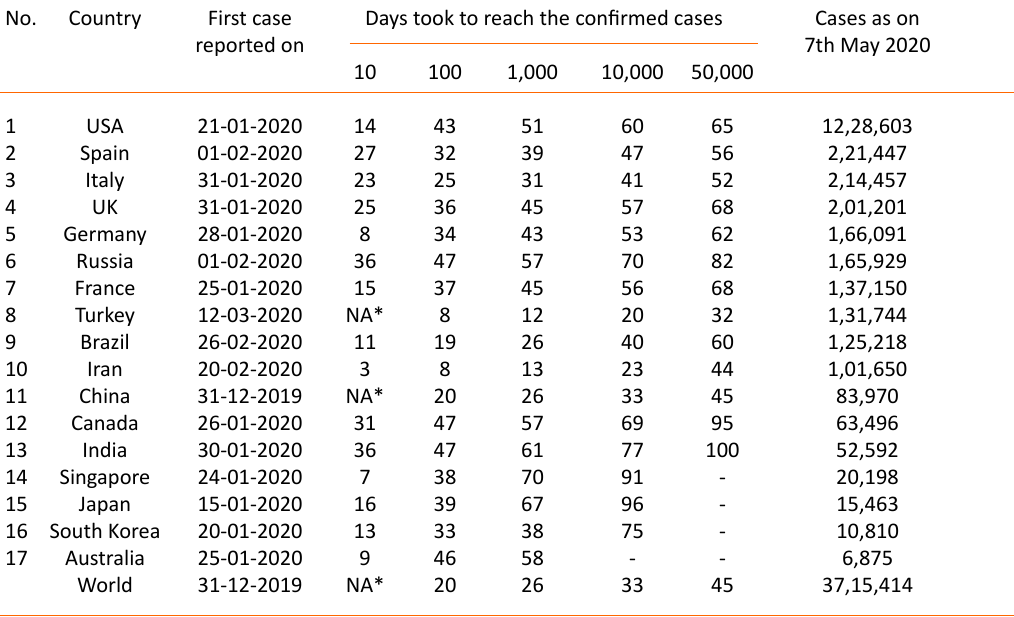
Table 1. Timeline (in number of days) reported for the cumulative total of confirmed cases of different countries 19